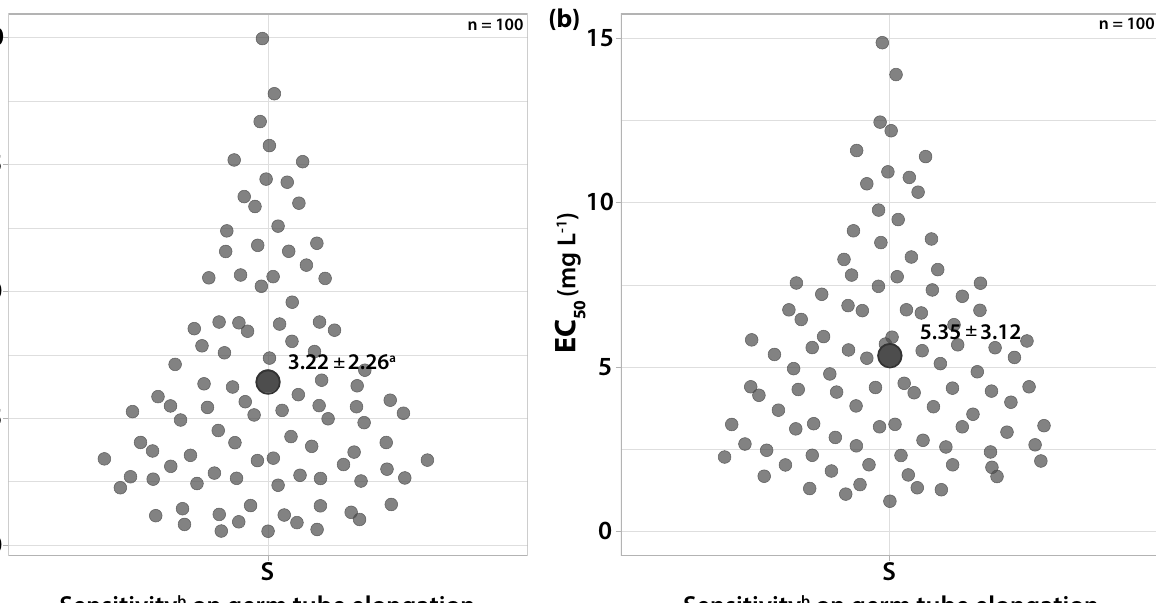
Figure 8. Frequency of sensitivity distribution for one hundred V. inaequalis isolates on germ tube elon- gation to ( a ) dithianon and ( b ) captan. a Average values of sensitivity groups ± standard deviation; circle size reflects the population number. b Sensitivity group: S,